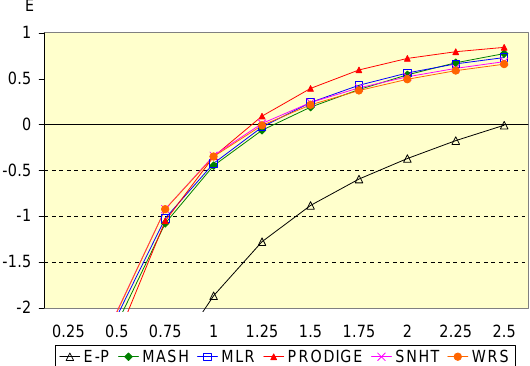
Figure 6. E ffi ciency in reducing RMSE when the IH-structure is the same as in Fig. 3. On the abscissa the unit is s d .